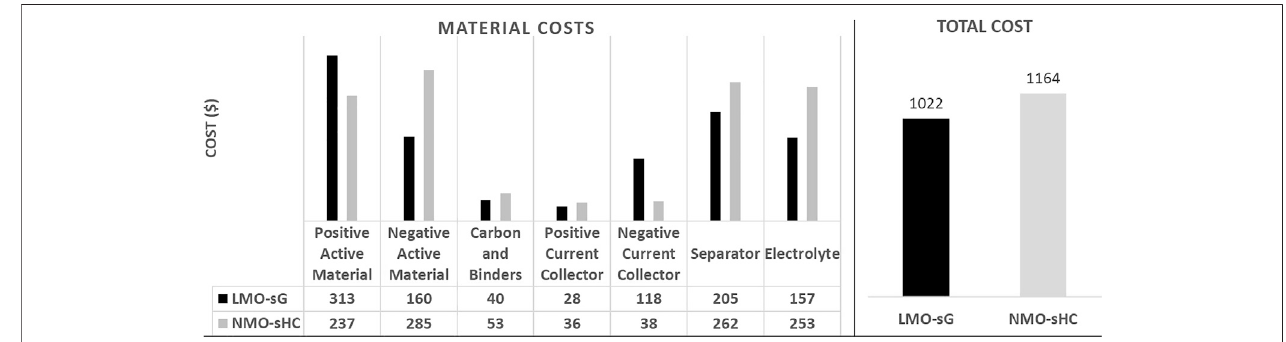
FIGURE 4 | Material costs of layered oxide cathode based lithium-ion batteries and SIBs. Data are redrawn from Vaalma et al. (2018).